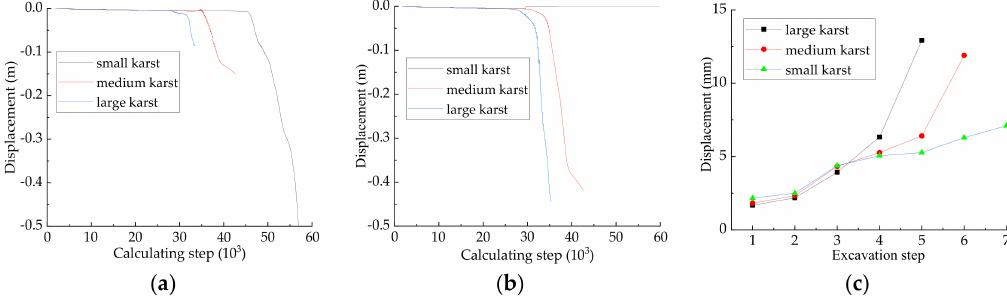
Figure 13. The changing displacement of monitoring points in the process of tunnel excavation. ( a ) Displacement of monitoring point − 6,0,0; ( b ) Displacement of monitoring point − 7,0,0; ( c ) Displacement of tunnel face